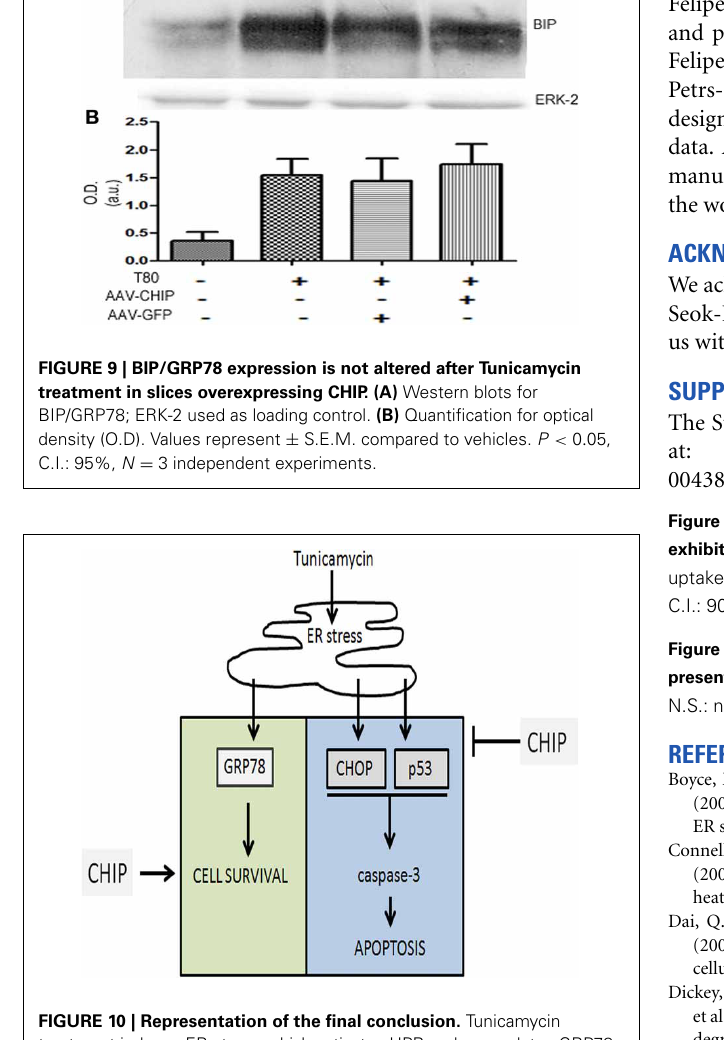
FIGURE 10 | Representation of the final conclusion. Tunicamycin treatment induces ER stress which activates UPR and upregulates GRP78, CHOP, p53. Overexpression of CHIP prevented cell death blocking upregulation of CHOP, p53, and caspase-3 activation, while maintain upregulation of GRP78 (BiP) and cell survival.